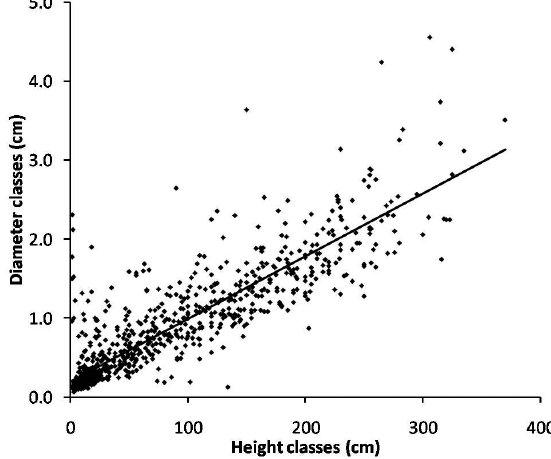
Fig. 2 – Relationship between stem diameter and height of the Rudgea parquioides (Rubiaceae) population in an Araucaria forest fragment in Curitiba, Southern